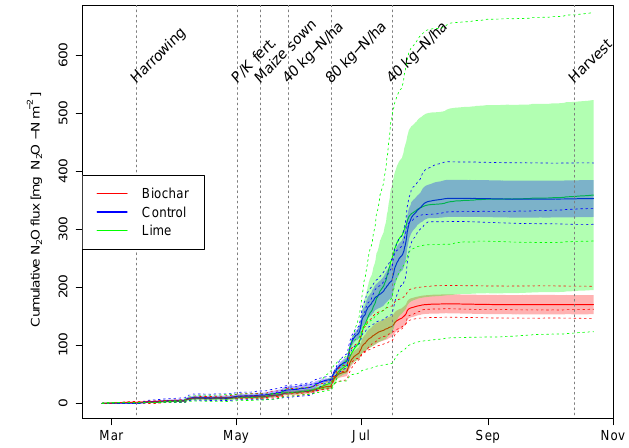
Figure 4. Mean cumulative N 2 O fluxes as solid lines. Shaded areas represent the standard error of the mean from the three replicates (dashed lines) per